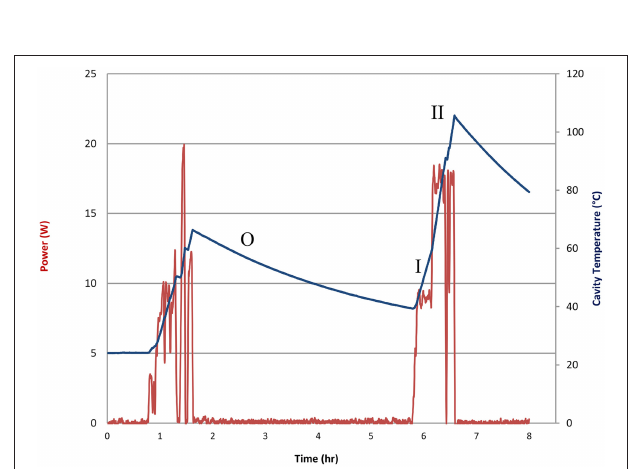
FIGURE 9 | Plots of average RF power (red) and cavity temperature (blue) as functions of time. The time period O corresponds to no RF power; I corresponds to RF on at 5% and II at 10% duty